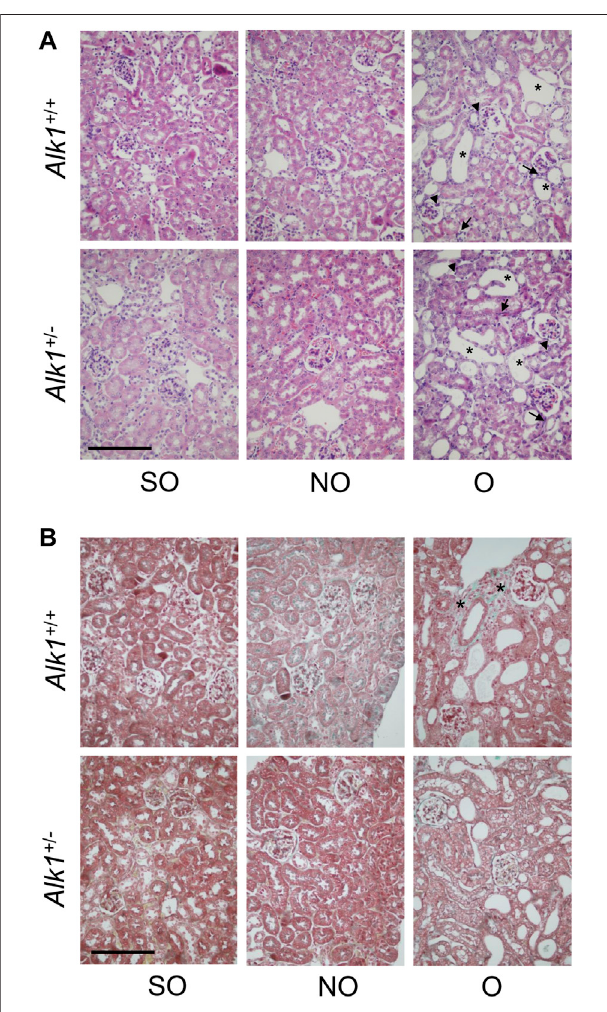
FIGURE 1 | UUO modi fi es the renal ultrastructure after 3 days in Alk1 +/+ and Alk1 +/ − mice. (A) Haematoxylin-eosin staining in SO, NO and O kidneys from Alk1 +/+ and Alk1 +/ − mice show the typical features of the early stages of UUO such as tubular dilatation (asterisk), interstitial cell proliferation (arrow) orimmunecellin fi ltration (arrowhead),being thesefeatures similar inO kidneys from Alk1 +/+ and Alk1 +/ − mice. (B) Masson ’ strichrome stainingin SO, NO and O kidneys from Alk1 +/+ and Alk1 +/ − mice showing lower ECM deposition (asterisk) in O kidneys from Alk1 +/ − . Scale bar = 200 microns in both panels.